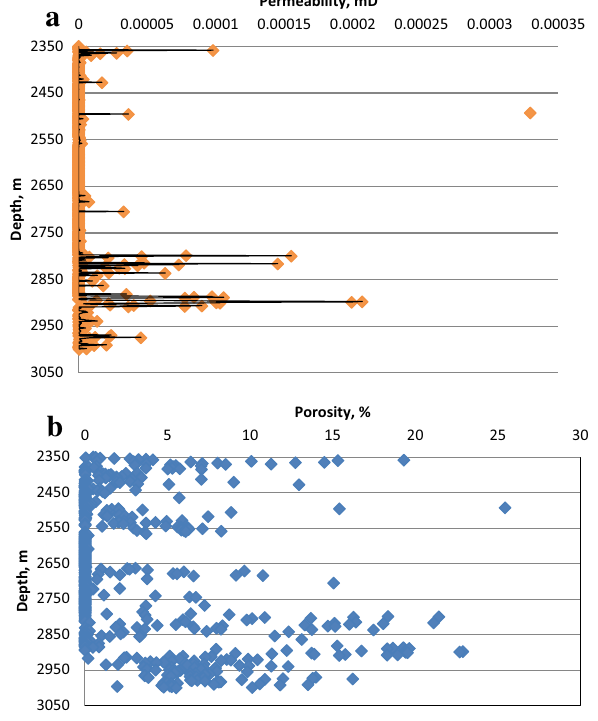
Fig. 15 a Depth–permeability cross-plot of Kömürlü Formation. b Depth–porosity cross-plot of Kömürlü